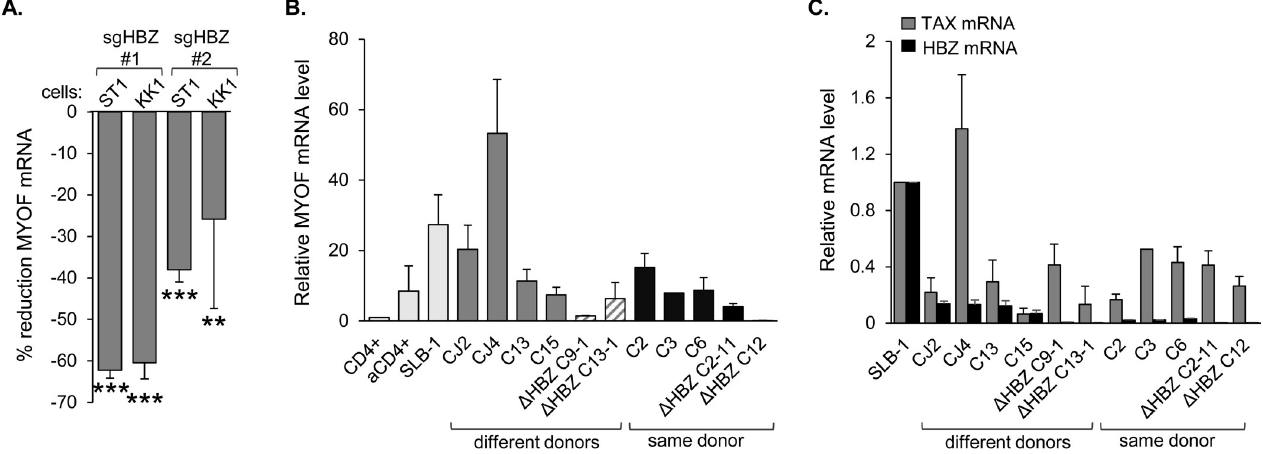
Fig 2. Expression of HBZ correlates with MyoF expression. (A) Deletion of HBZ in ST1 and KK1 ATL cells reduces MYOF expression. The graph was generated from published microarray data (GEO accession number GSE94409 [56]) and shows the percent reduction in MYOF transcript levels seven days after inducing CRISPR/Cas9-mediated knockout of HBZ in the ATL cell lines, ST1 and KK1, using two different guide RNAs (sgHBZ #1 and #2) compared to the guide RNA control. Data were obtained using GEO2R with calculations based on averaged values from the three array features probing for different regions of the MyoF transcript; �� p < 0.01, ��� p < 0.001. (B) Relative MYOF mRNA levels in HTLV-1-immortalized human T-cell clones recently established from peripheral blood lymphocytes (PBL). The graph shows qRT-PCR results as follows: C3, value from one RNA extraction; Δ HBZ clones, values averaged from two extractions; all others, values averaged from three extractions. Values were normalized to those for the resting CD4 + T-cells (set to 1). Dark gray bars show clones derived from different PBL donors immortalized with HTLV-1-wt (CJ2, CJ4, C13, C15). Hatched bars show clones derived from different PBL donors immortalized with HTLV-1- Δ HBZ (C9-1 and C13-1). Black bars show clones immortalized with either HTLV-1-wt or HTLV-1- Δ HBZ derived from the same PBL donor (C2, C3, C6, C2-11 and C12). Light gray bars show a subset of cells also analyzed in Fig 1C for comparison. (C) Relative tax and hbz mRNA levels in HTLV-1-immortalized human T-cell clones recently established from PBL. The graph shows qRT-PCR results averaged from the same set of RNA specimens analyzed in (B) in which values were normalized to those for the SLB-1 T-cells (set to 1).